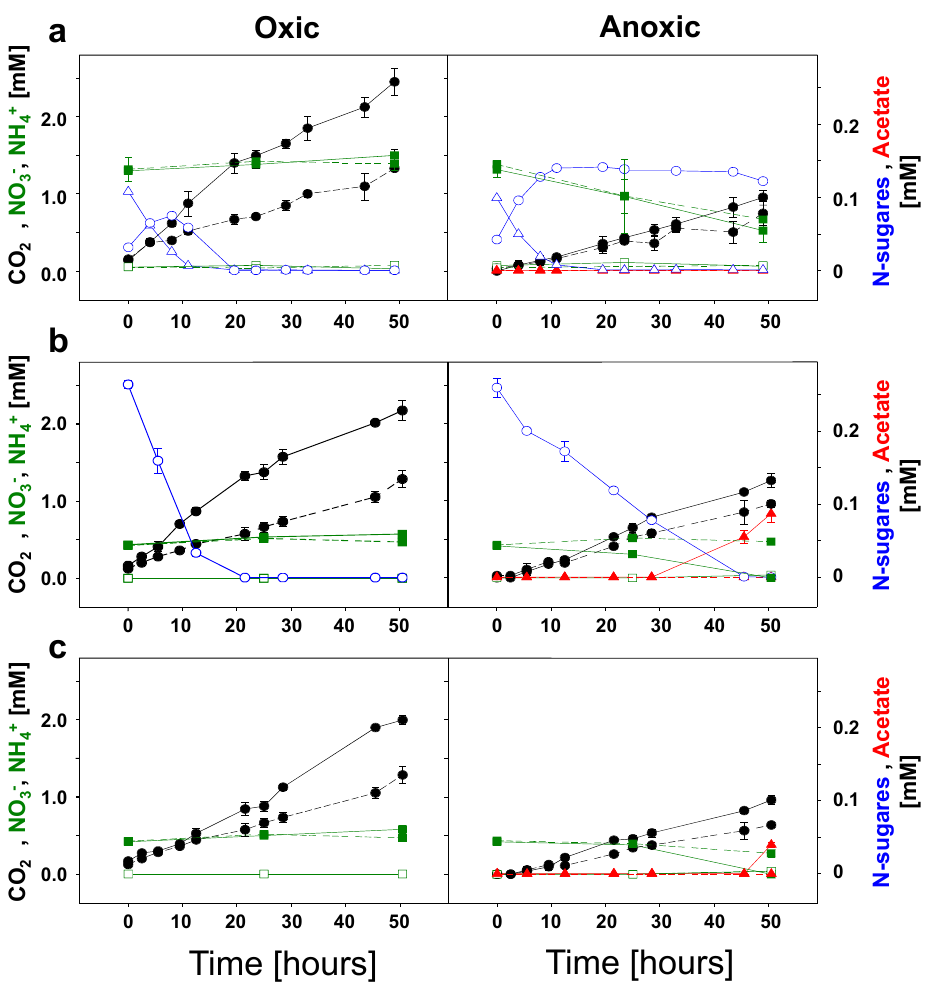
Figure 2. Product formation of soil slurries supplemented with [GlcNAc] 2 (a) , GlcNAc (b) , and GlnN (c) . Left panels, slurries incubated under oxic atmosphere. Right panels, slurries incubated under oxygen-free atmosphere. Closed black circle, carbon dioxide. Open blue circle, GlcNAc. Open blue triangle tip up, [GlcNAc] 2 . Closed red triangle tip up, acetate. Closed green rectangle, nitrate. Open green rectangle, ammonium. Dashed lines, values of the unsupplemented controls. Error bars, standard deviation of replicated soil slurries ( n = 3). In some cases these errors were so small that they are masked by the symbol. GlcN was not detectable with the employed HPLC